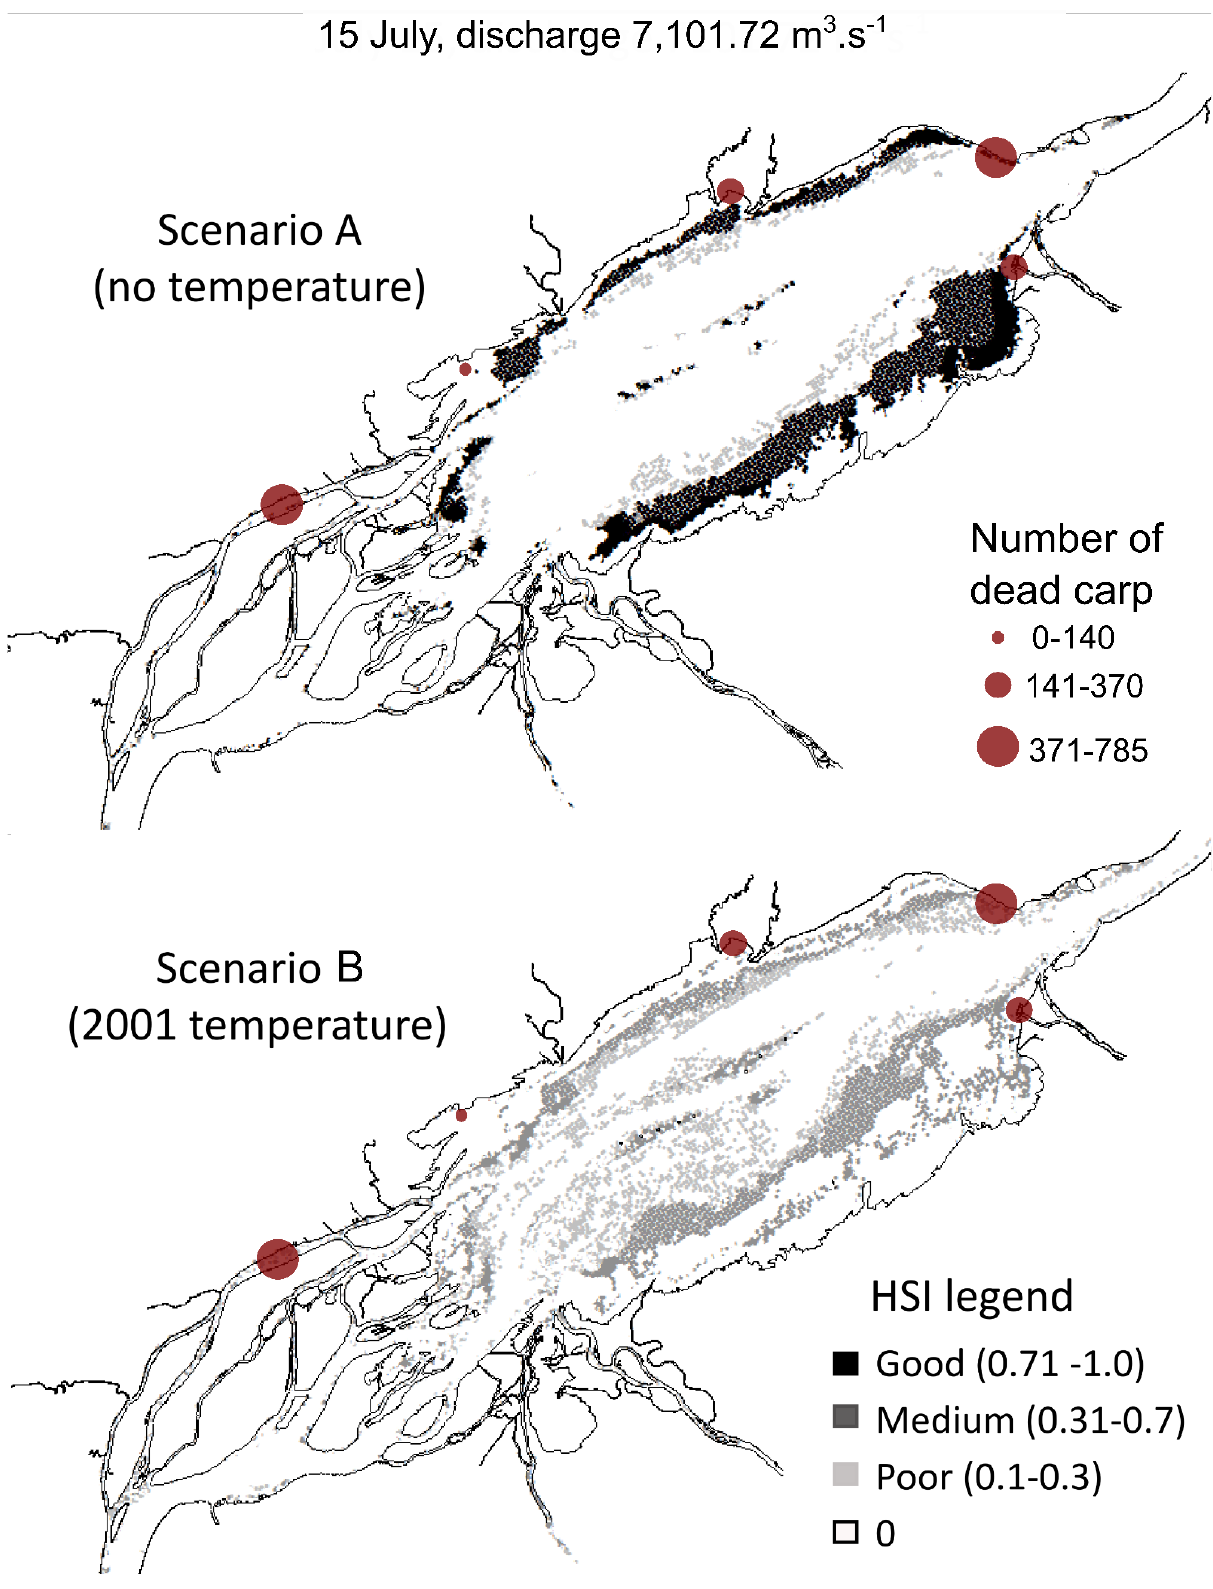
Figure 6. Spatial distribution of habitat suitability index (HSI) for the carp spawning habitat in the Lake Saint-Pierre area simulated for 15 July 2001, a few days before the mortality event began. Two scenarios were computed: ( A ) excluding water temperature and ( B ) including water temperature as simulated for